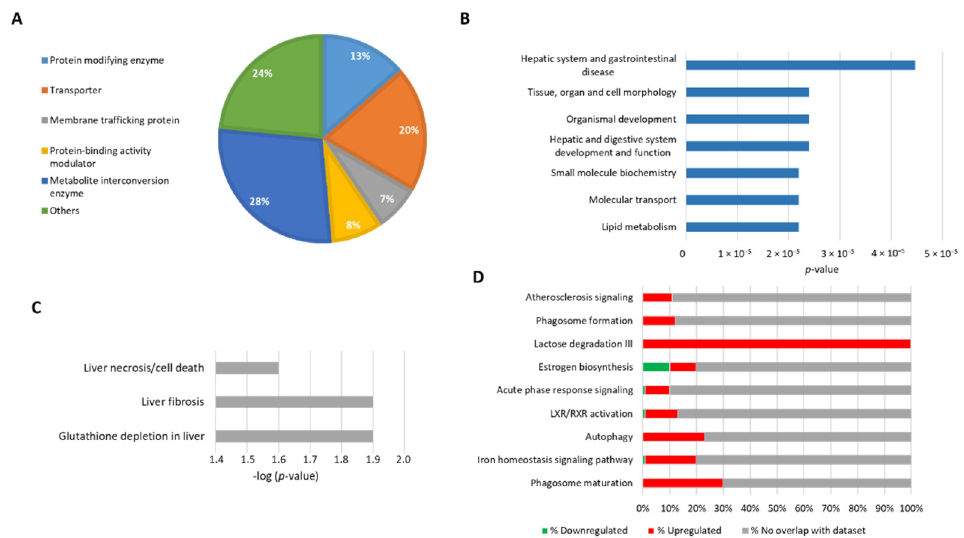
Figure 2. Disease and bifunctional analysis of the differential proteome of hepatocytes obtained from wild type and Npc1 − / − mice. ( A ) Pie chart showing different functional classes of proteins based on the PANTHER database. ( B ) Top toxicity-related protein list from the sets of 155 altered proteins (upregulated and downregulated) that are known to be involved in a specific type of toxicity. Significance was determined using a right-tailed Fisher’s exact test to determine the probability of pathways from the IPA Knowledge Base Library of those most significantly enriched. ( C ) Top toxicity-related proteins list filtered by hepatotoxicity. ( D ) The bar chart represents the top canonical signaling pathways that were influenced by the NPC phenotype, p -values were determined using Fisher’s exact test with a threshold value of > 0.05. Ratios represent the percentage of genes from the data set that map to each canonical pathway showing those that are upregulated (in red) and downregulated (in green).